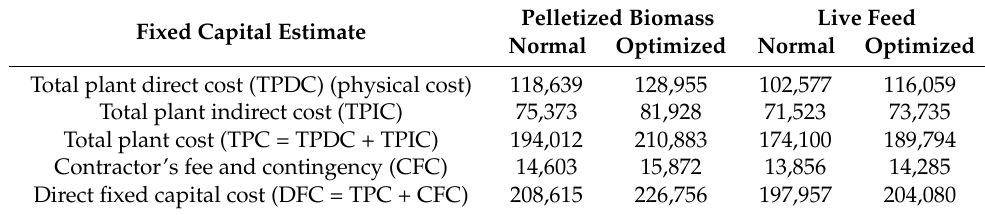
Table 3. Fixed capital estimate for two scenarios of biomass production using Chlorella